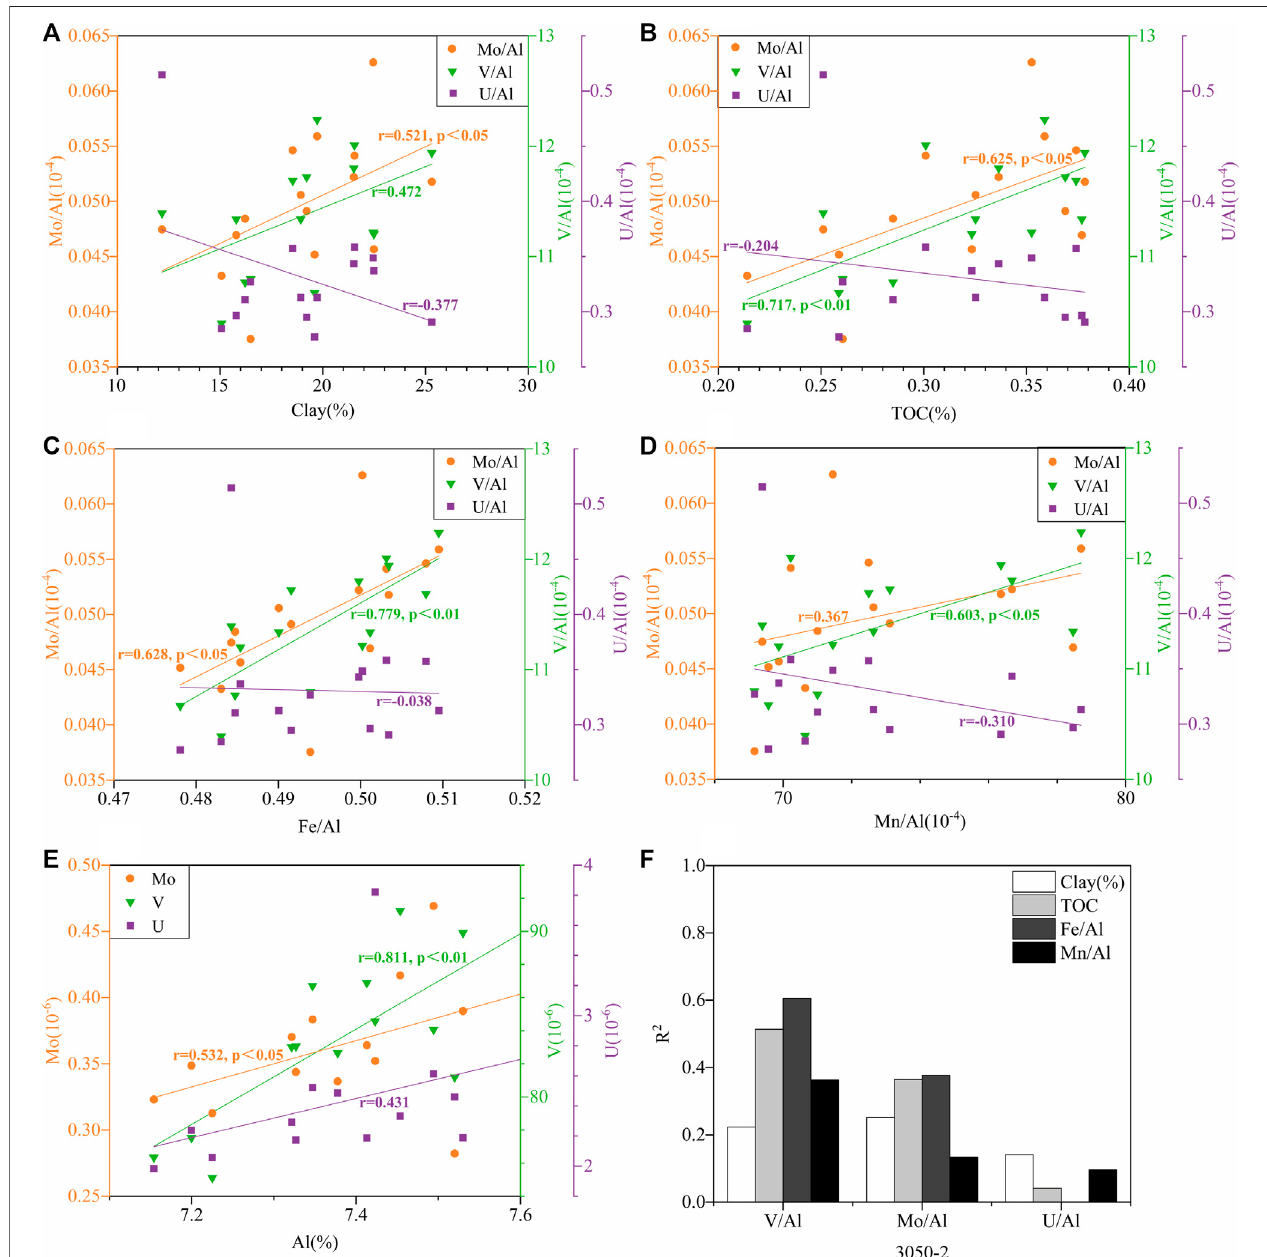
FIGURE 4 | Correlation between RSE/Al values and clay proportion (A) , TOC (B) , Fe/Al value (C) , Mn/Al value (D), and their R 2 (F) ; correlation between RSEs and Al (E) .